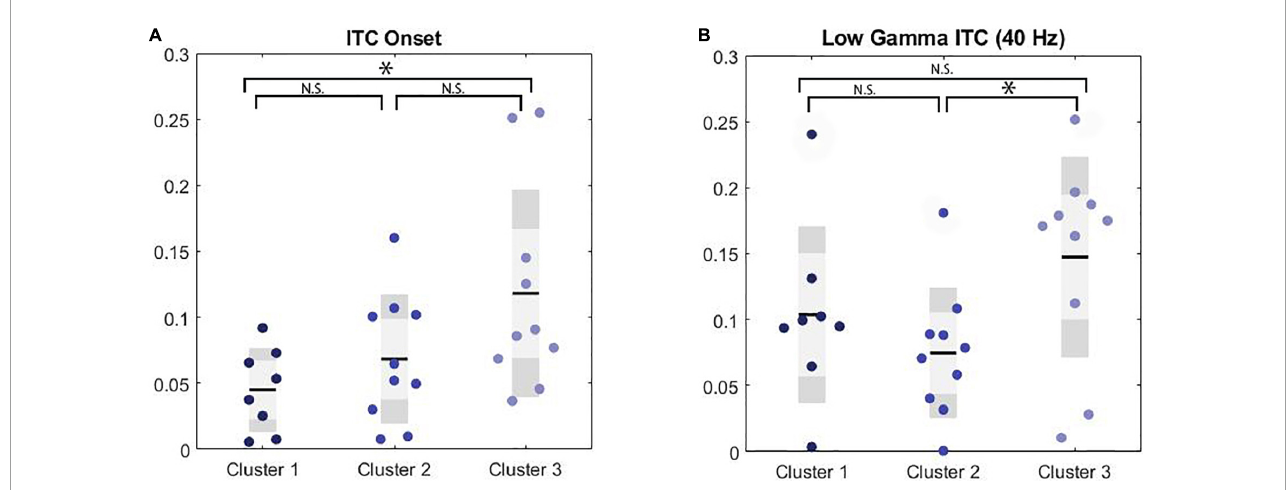
FIGURE2 Significance markers reflect non-corrected MANCOVA results. N.S. = not significant, ∗ p < 0.05. (A) Boxplot depicting group comparison across clusters for ITC to the onset of the chirp stimulus showed overall significance ( p = 0.04) where cluster 1 showed a trend toward significantly lower ITC than cluster 3 ( p = 0.05). (B) Boxplot depicting group comparison across clusters for low gamma ITC with significant overall ( p = 0.04) where cluster 2 showed significantly lower ITC than cluster 3 ( p = 0.03).